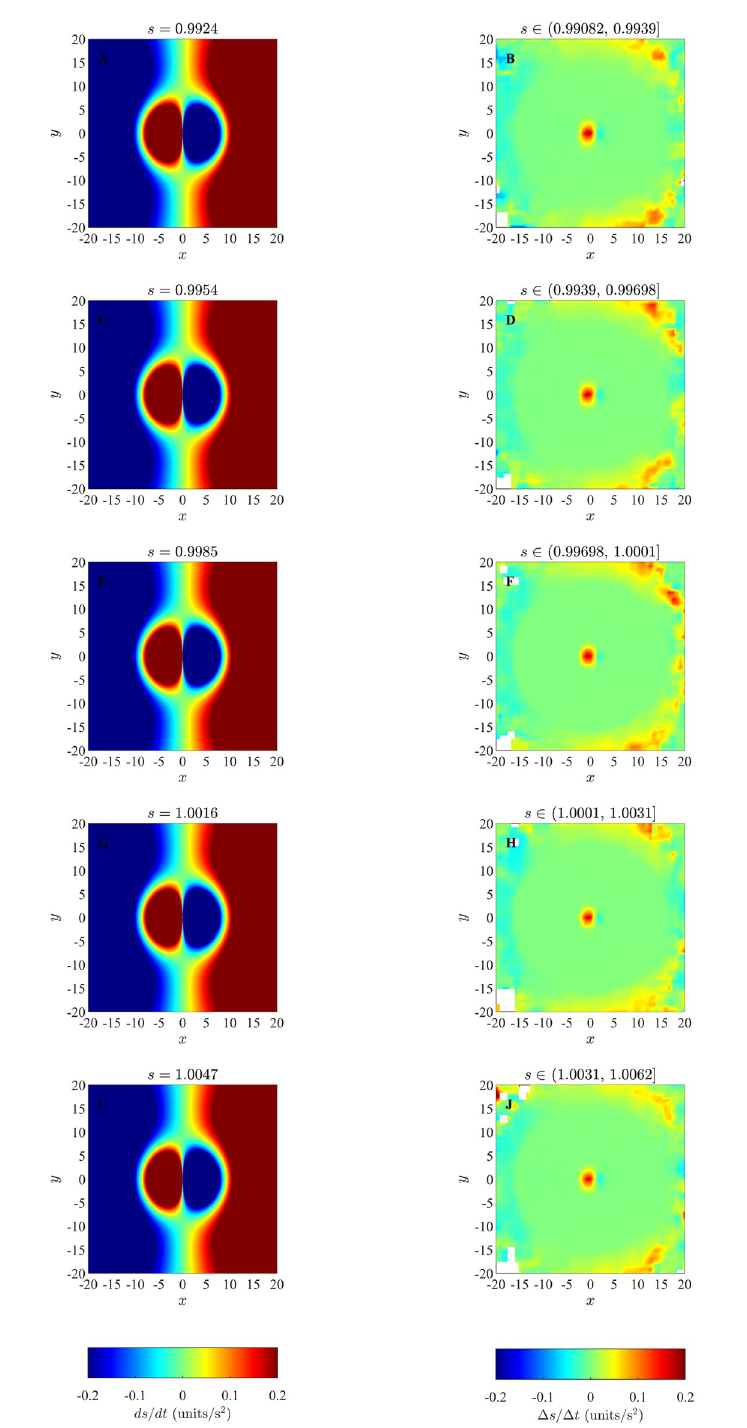
Fig 11. Left column: analytical pairwise changes in speed as prescribed by the ODE model (equation (S3.18)) for groups that undergo parallel motion (item (c) from Table 3). Right column: results obtained via the averaging method. (Derived from simulations with N = 10 individuals over 10000 time